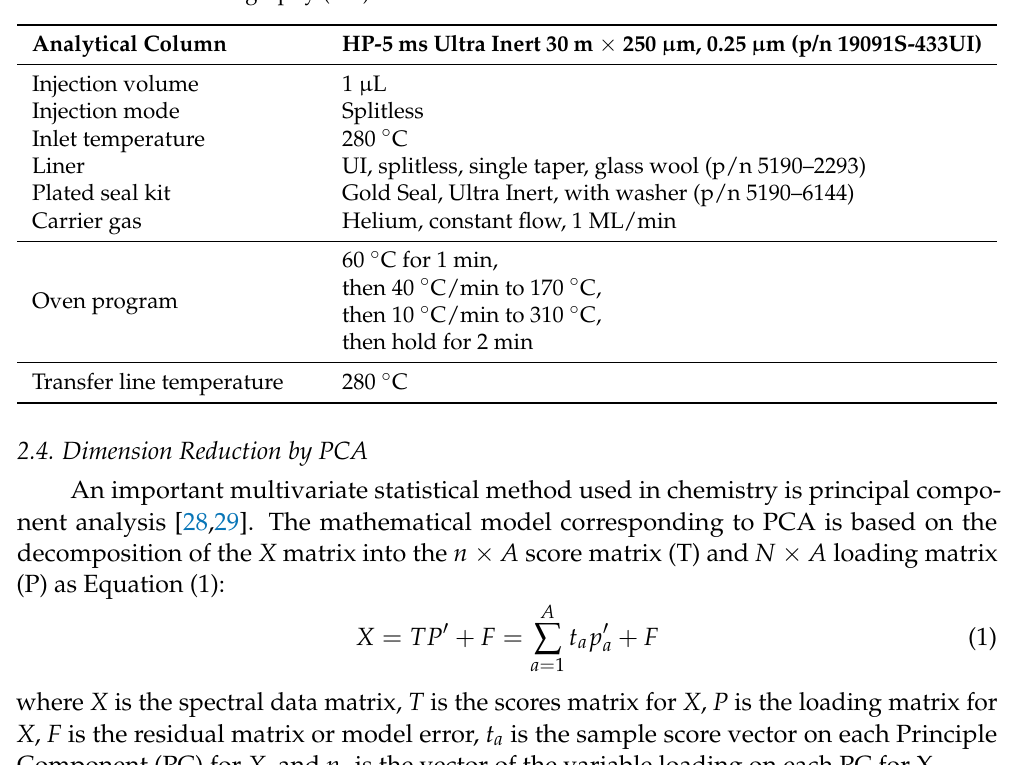
Table 2. Gas Chromatography (GC) run